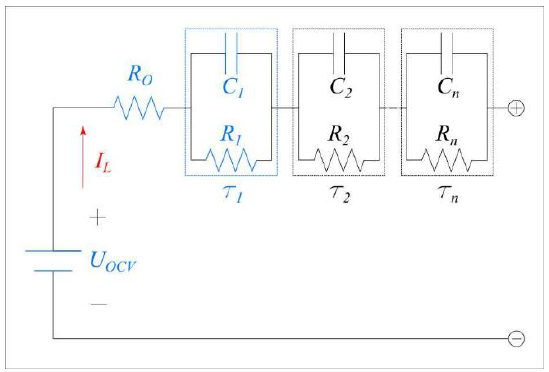
Figure 4. Overall comprehensive battery simulator with all four sub-models.